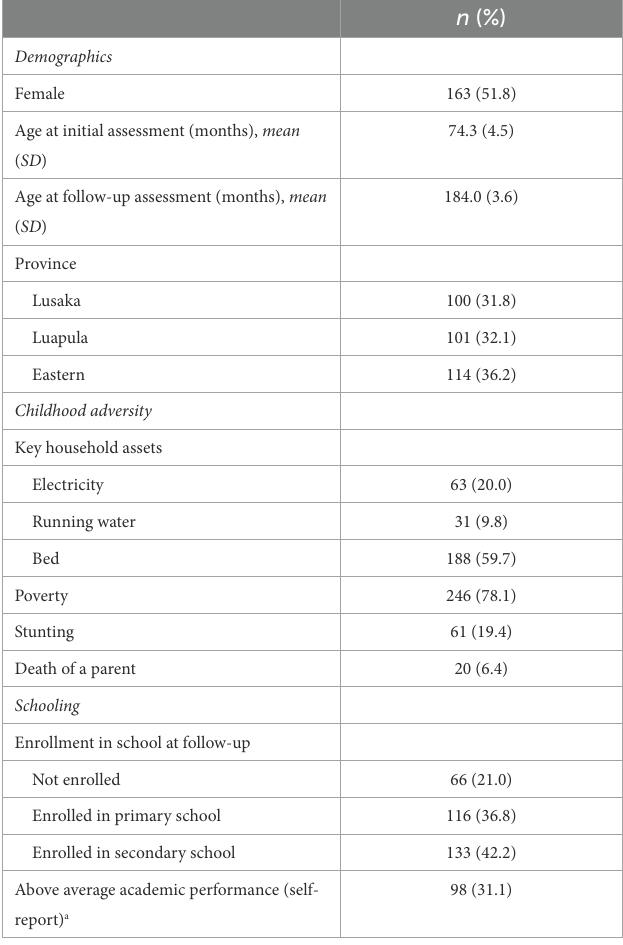
TABLE 1 Description of study participants ( N = 315).